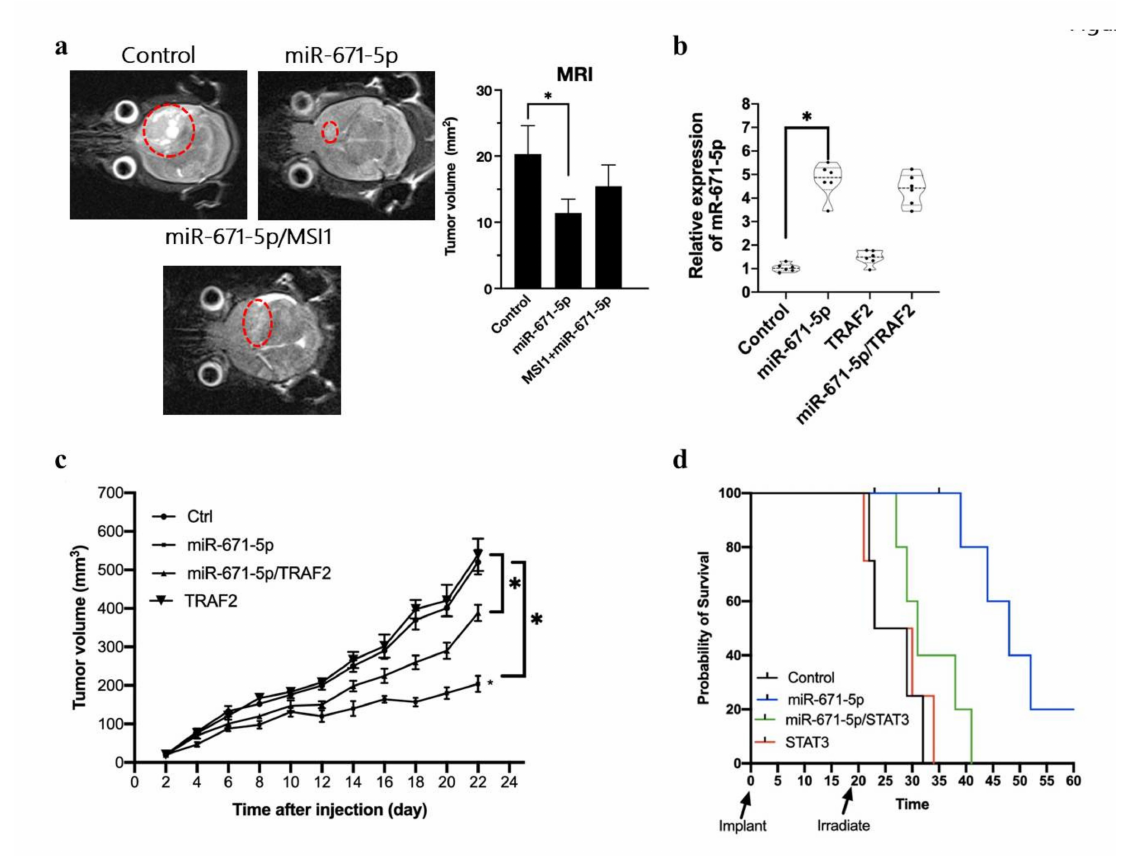
Figure 5. MSI1 attenuates the miR-671-5p mediated inhibition in tumour size. ( a ) 3T-MRI photogra- phy showing the transplanted tumor in Nude/SCID mice. The transplanted tumor is labelled with the dotted circle. Besides the subcutaneous transplantation, we also transplanted the miR-671-5p, miR-671-5p/MSI1 overexpressed and control U87MG cells into the brain and assayed the survival rate of mice. ( b ) qRT-PCR analysis of miR-671-5p expression of transplanted miR-671-5p, TRAF2, miR-671-5p/TRAF2, and control tissue in mice. The mRNA level is quantified relative to the control group and presented as the mean from three independent experiments with SD error bars. An asterisk indicates a statistically significant difference (Student’s t -test, p < 0.01). ( c ) The tumor growth rate was measured every other day. Variations in tumor volume (mm3) overtime in four treatment groups: miR-671-5p, TRAF2, miR-671-5p/TRAF2, and control cells. All groups were irradiated (3 Gy) before transplantation and culture for two passages and then transplanted into mice. Twenty-two days after transplantation, we harvested all the samples for further analysis. Error bars represent standard deviation (SD). The symbol denotes significance ( p < 0.001) relative to control. ( d ) The survival rate analysis of miR-671-5p, STAT3, miR-671-5p/STAT3 overexpressed and control cells after irradiation. We irradiated the mice on day 20 and observed the survival rate within 60